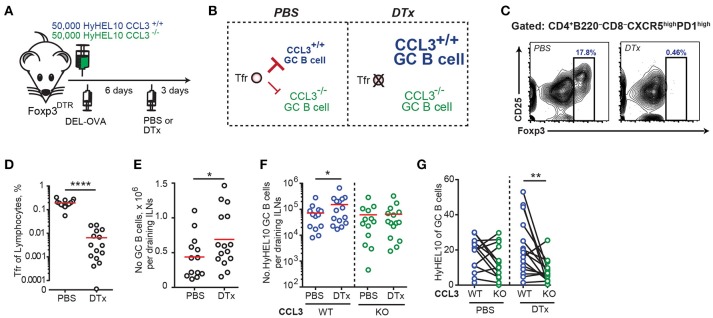
Tregs repress B cell participation in GCs at 9 d.p.i. in a CCL3-dependent way. (A) Experimental outline. FoxP3DTR recipient mice were transferred with HyHEL10 B cells, immunized with 50 μg DEL-OVA in Ribi s.c. and then treated either with PBS or 5 μg DTx in PBS i.p. 3 days before analysis. (B) Suggested model of CCL3-dependent regulation of GC B cells by Tfr cells and prediction for CCL3+/+ and CCL3−/− GC B cell participation in GCs upon ablation of Tfr cells at 9 d.p.i. (C–G) Flow cytometry analysis of cell participation in immune response at 9 d.p.i. in DTx-treated and control mice. (C–E) DTx-mediated depletion of Tfr cells at 9 d.p.i. Representative example of Tfr ablation (in C) and Tfr fraction of total lymphocytes (in D) and increase in GC response in DTx-treated mice (in E). (F,G) CCL3+/+ and CCL3−/− HyHEL10 GC B cells in PBS and DTx-treated mice shown as the total numbers of cells in dLNs (F) or as the % of total GC B cells (in G). The data are from five independent experiments. Each dot represents a single mouse and red lines correspond to the mean values. Paired analyses are indicated using solid black line. *p < 0.05, **p < 0.01, ****P < 0.0001. Two-sided (in D,G) or one-sided (in E,F) Student's t-test.